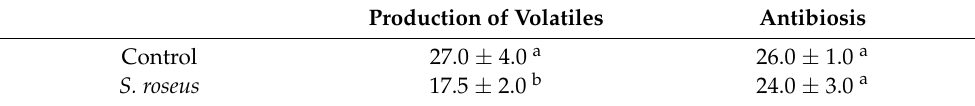
Table 2. Results of antibiosis and production of volatiles in vitro tests. Data (colony diameter, mm) are the mean of three replicates ± standard error of the mean (SEM). For each parameter, values with different letters are statistically significant ( p ≤ 0.05) according to Duncan’s Multiple Range Test (DMRT).